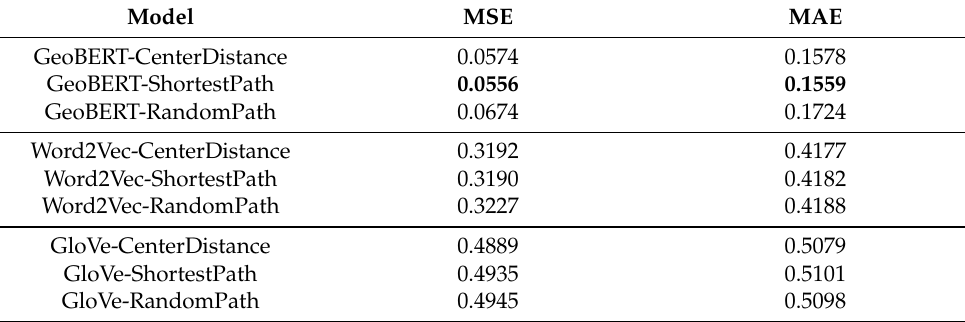
Table 12. Evaluation on house price prediction.